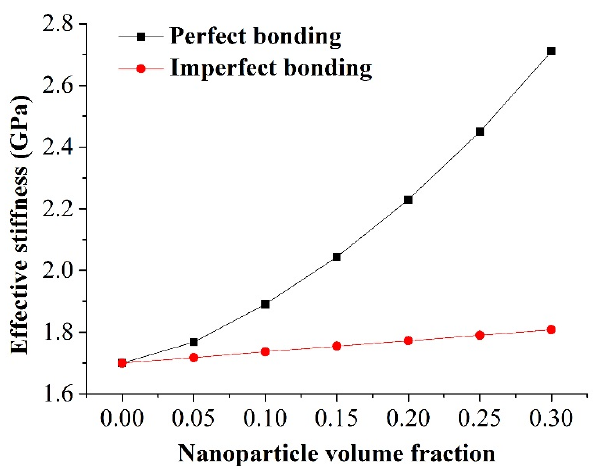
Figure 4. Effect of bonding condition between the interphase and the matrix on the effective stiffness of